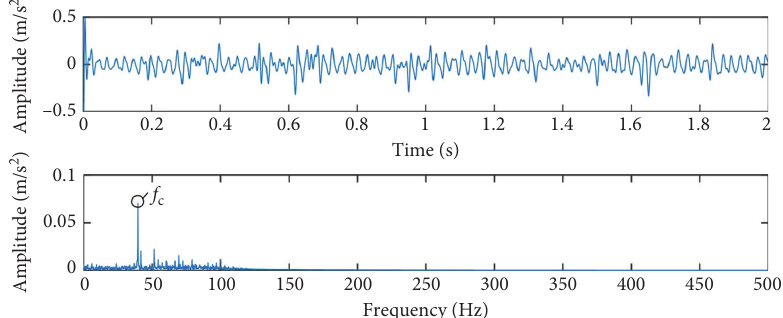
Figure 20: Signal processed by TFSR.